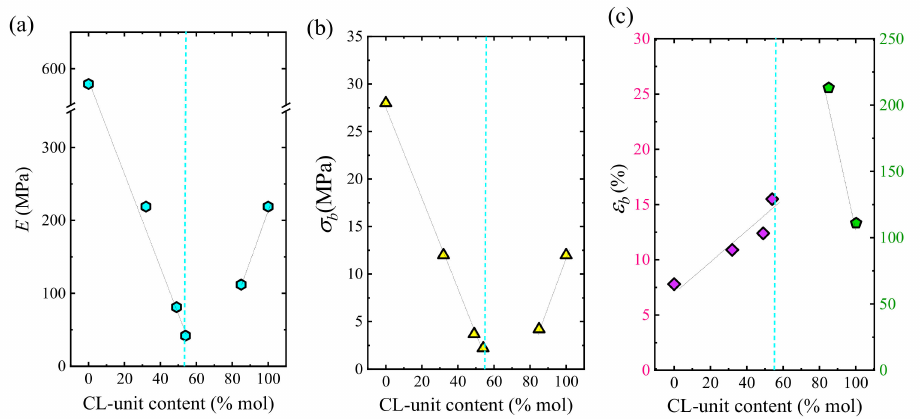
Figure 15. Mechanical properties of HM W -BS x CL y random copolyesters obtained from stress-strain curves. The elastic modulus E ( a ), the stress at break σ b ( b ) and the elongation at break ε b ( c ) values are shown versus CL-unit content. The dotted blue line is the pseudo-eutectic